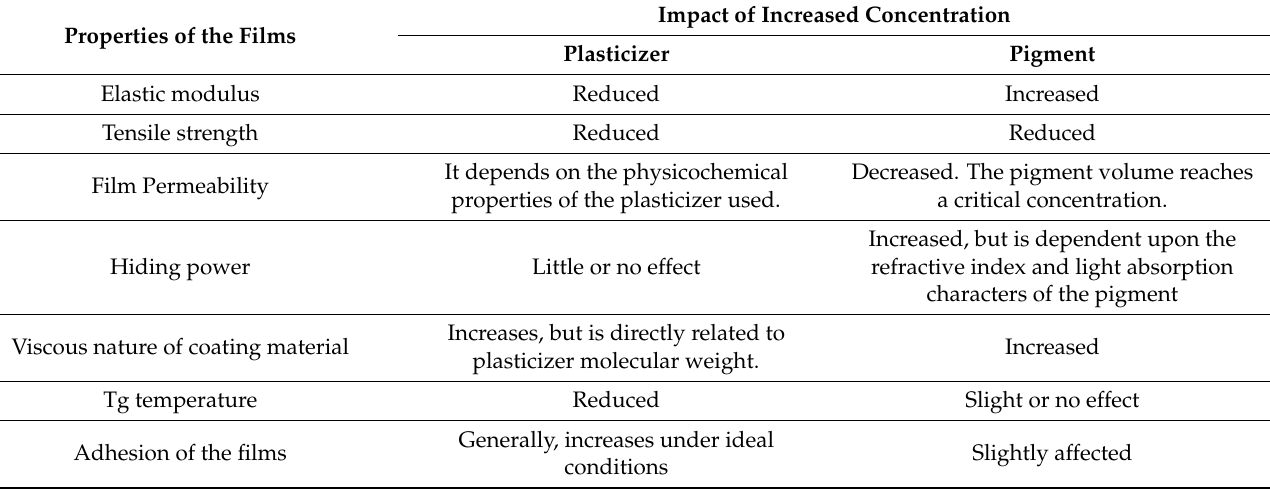
Table 7. Effect of plasticizer and pigments in FC